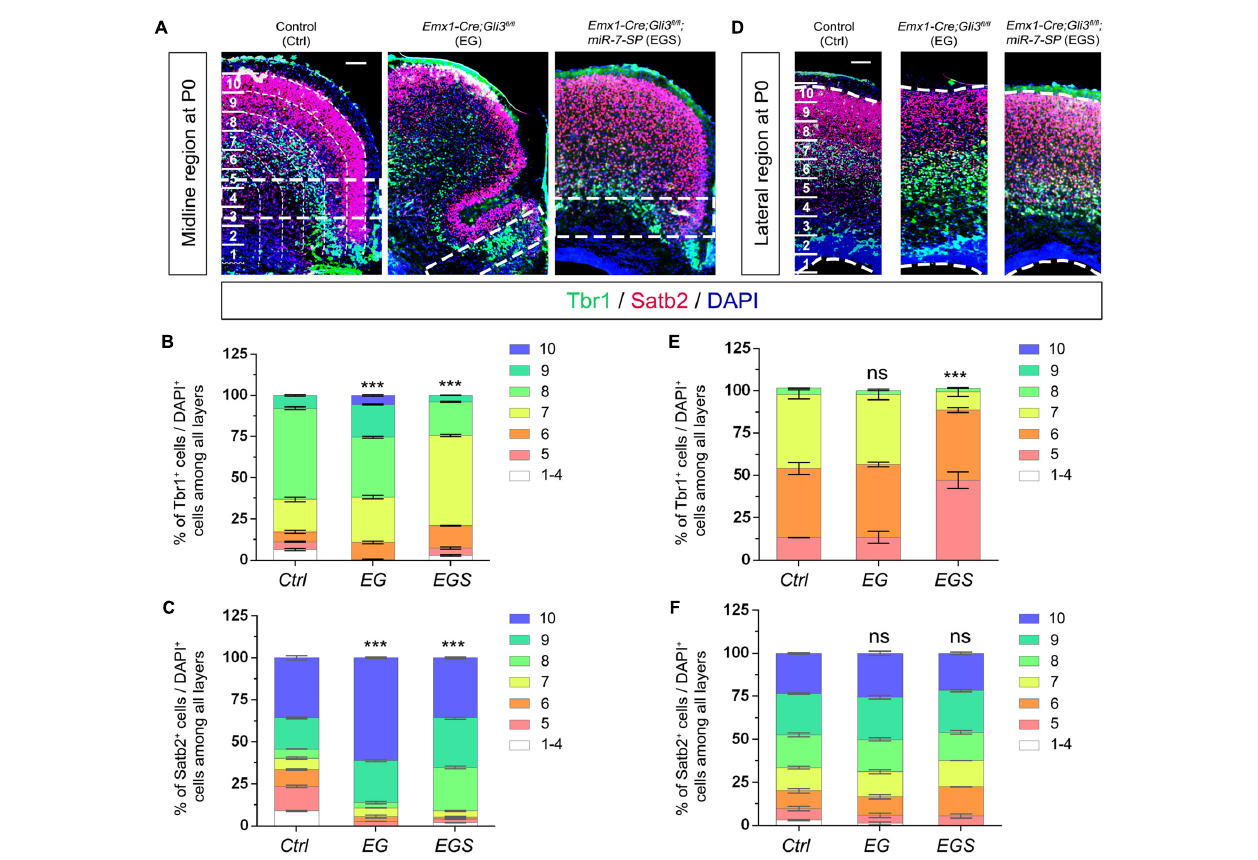
FIGURE 7 | The regulatory role of Gli3 and miR-7 in modulating neuronal migration in the P0 cortex. (A–C) Absence of Gli3 facilitated more Tbr1 + and Satb2 + marked neurons to migrate into the upper bins in the midline region, while double-lose of miR-7 and Gli3 partially corrected the migratory process. (D–F) Subtle alteration of migratory process was detected in the upper bins in the cortical lateral region in EG and EGS brains. The markers Tbr1, Satb2 and DAPI stained for deeper bin newborn neurons, upper-bin newborn neurons and all cells, respectively. Values represent mean ± SEM. n > 9. ∗∗∗ P < 0.001; ns, not significant. One-way ANOVA with post hoc test was used. Scale bar = 100 µ